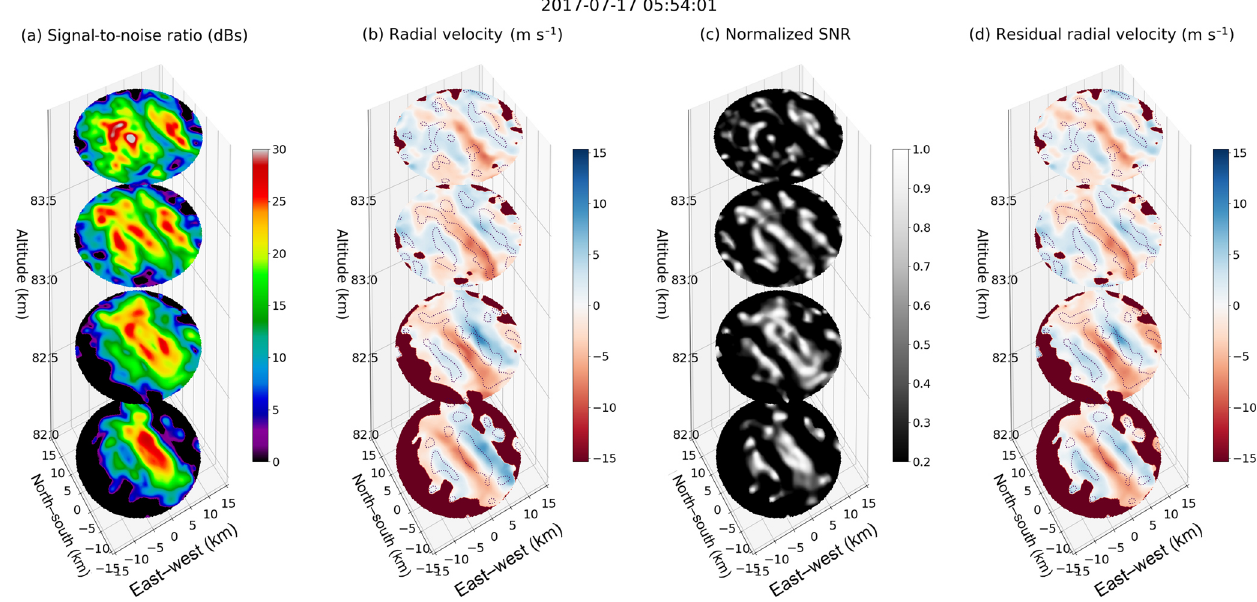
Figure 9. Same as Fig 8, but at 05:54:01UT on 17 July 2017 for altitudes 82, 82.7, 83.4, and 84km., i.e., Event